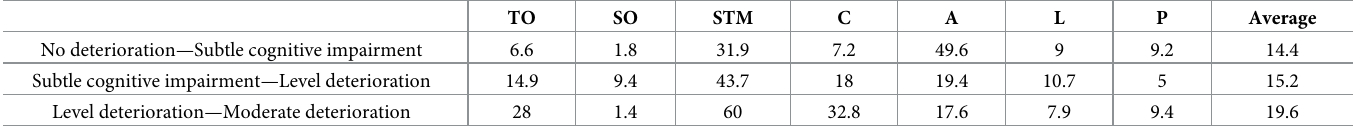
Table 3b. Percentages of the relative deterioration between consecutive levels. TO SO STM C A L